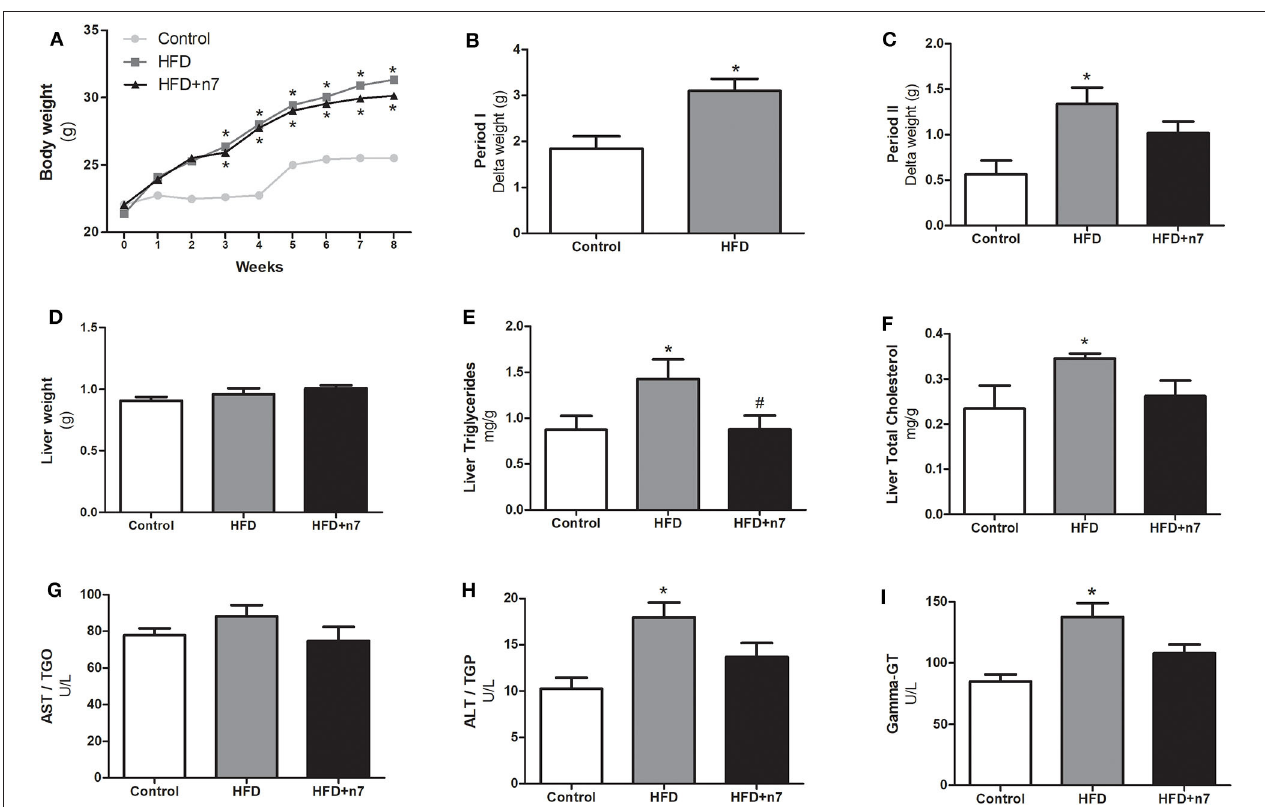
FIGURE 1 | Weight gain curve (A) , Body mass gain in period I (B) and II (C) , liver mass (D) , hepatic triglyceride in mg/g of liver weight (E) , total hepatic cholesterol in mg/g of liver weight (F) , AST (G) , ALT (H) , and γ -GT (I) levels in U/L in plasma. In period I (weeks 1–4), the animals received control or high-fat diet (HFD). In period II (weeks 4–8), the diets were maintained, and the animals received either water (control and HFD groups) or palmitoleic acid (HFD + n7 group) by oral gavage. Results were expressed as mean ± SEM ( n = 12). Data were analyzed by one-way ANOVA. * p < 0.05 vs. control, # p < 0.05 vs.